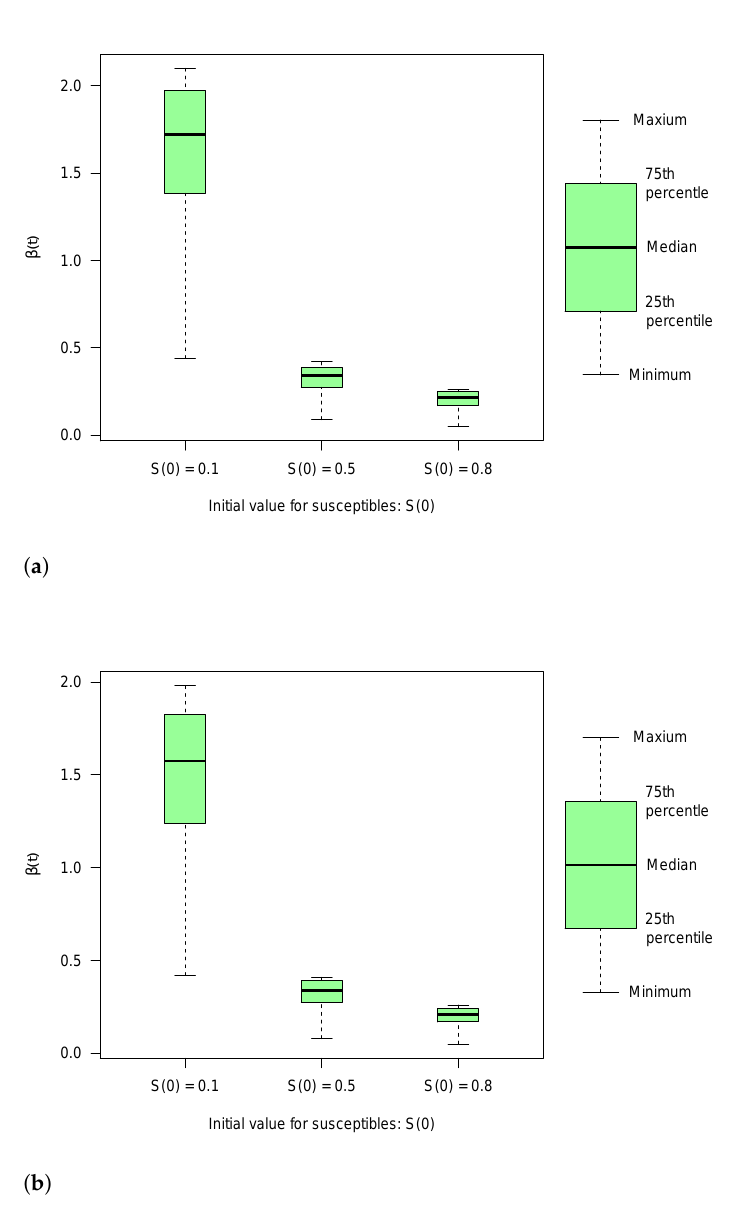
Figure 6. Box-and-Whiskers plot for estimates of β ( t ) for two different values of µ in a Visceral Leishmaniasis outbreak: ( a ) Estimates for µ = 0.0; ( b ) Estimates for µ =